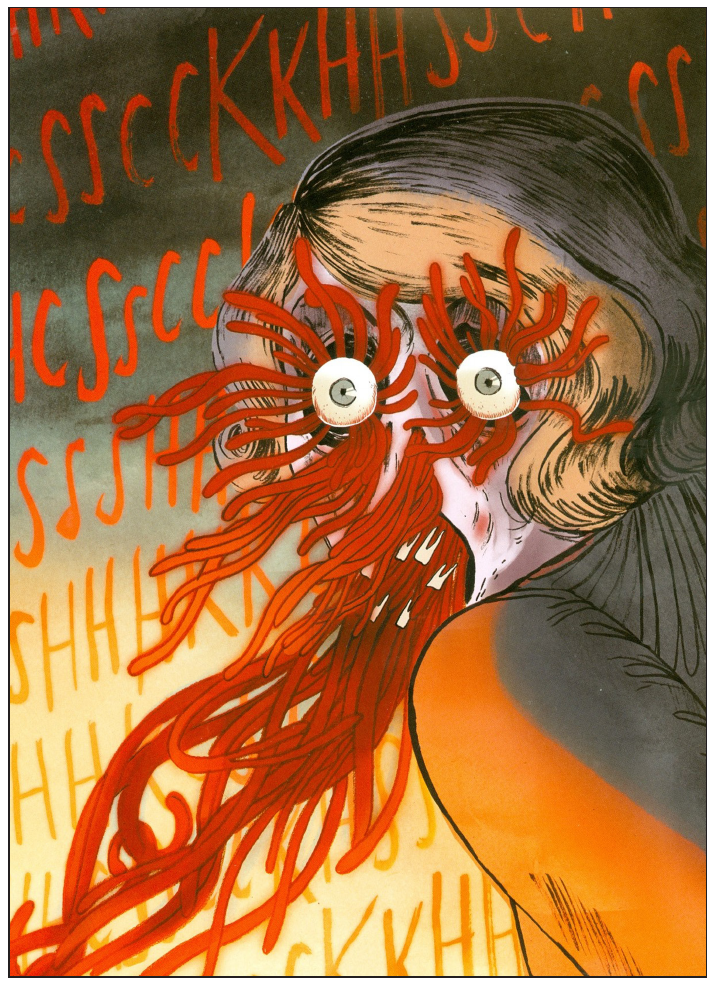
Figure 5: Carroll, E (2014). Through the Woods (New York: Faber & Faber, n.pag.) © Emily